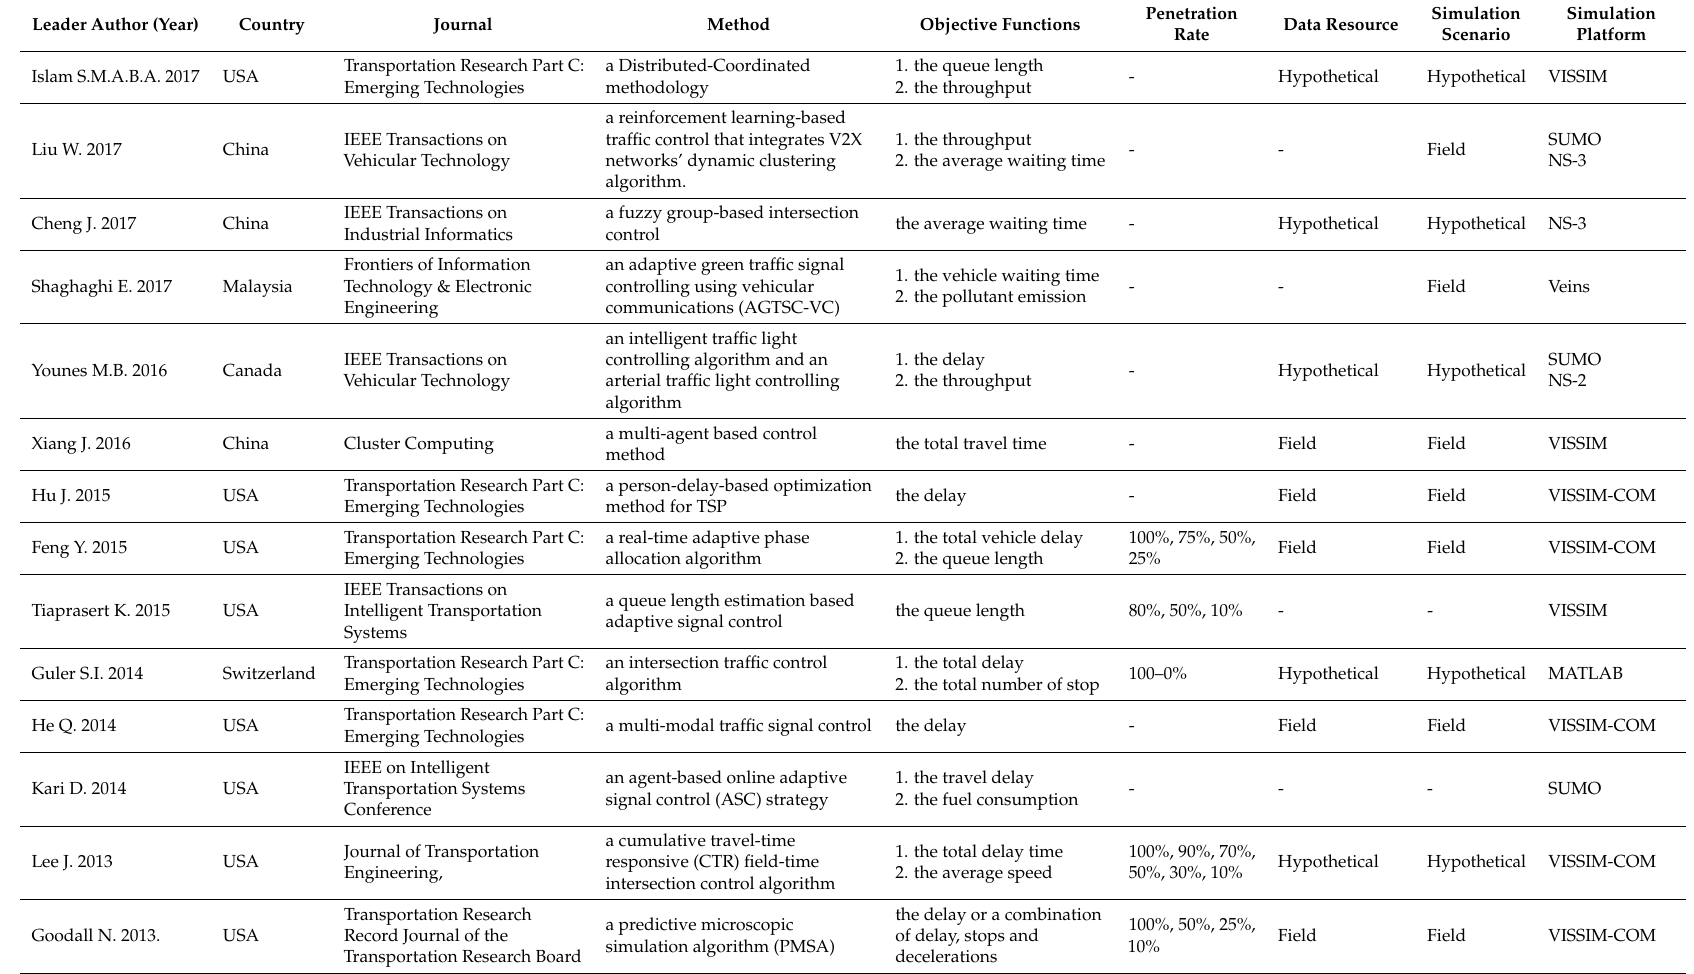
Table 2. Summary of studies included in this systematic